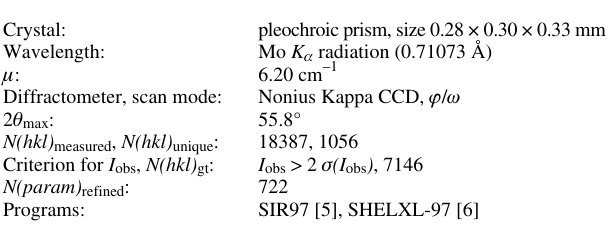
Table 1. Data collection and